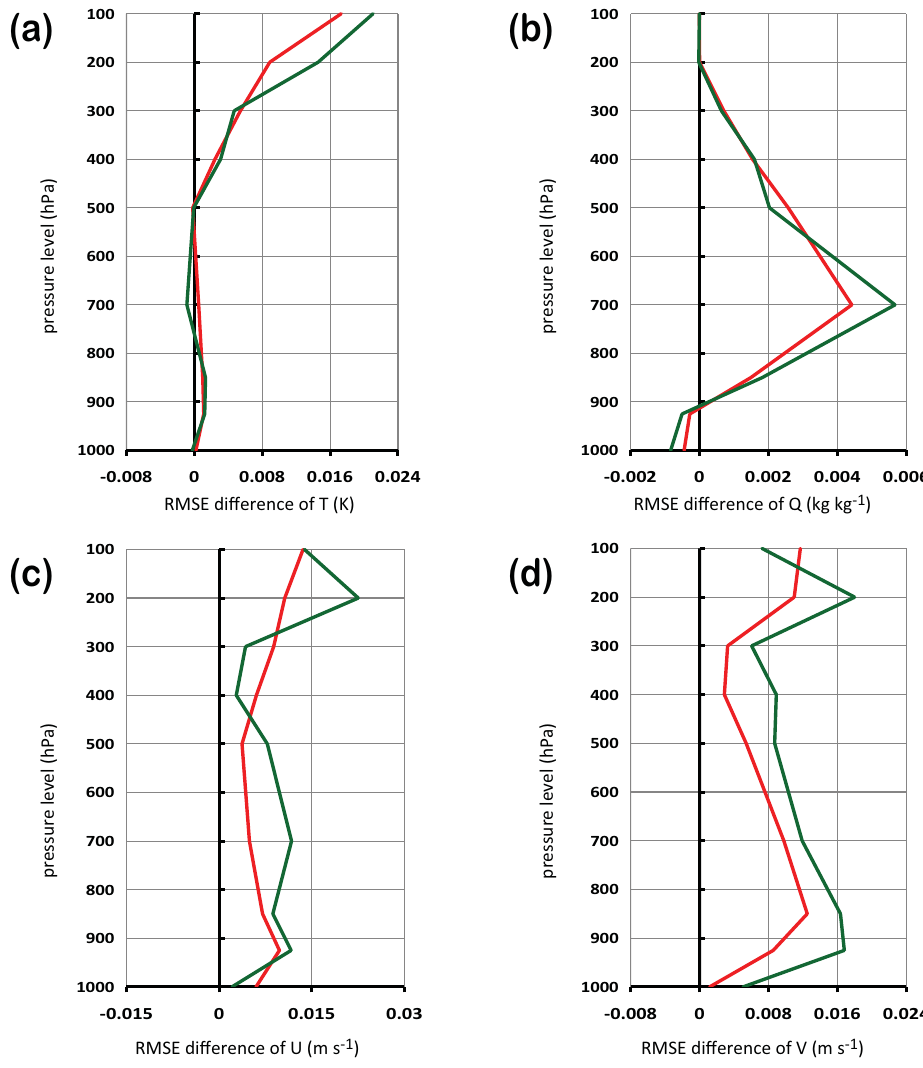
Figure 6. PNG-PWG difference of 00 to 72h forecast average of RMSE for (a) temperature, (b) mixing ratio of water vapor, (c) zonal wind, and (d) meridional wind. The red line is the mean of 00:00/12:00UTC cycles, the green line is the mean of 06:00/18:00UTC